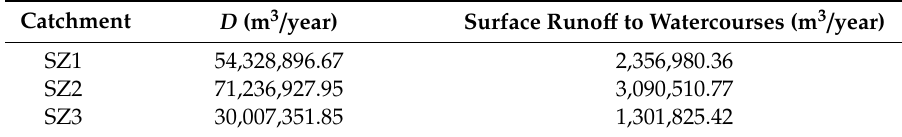
Table 7. Main water balance variables for the pre-development state.